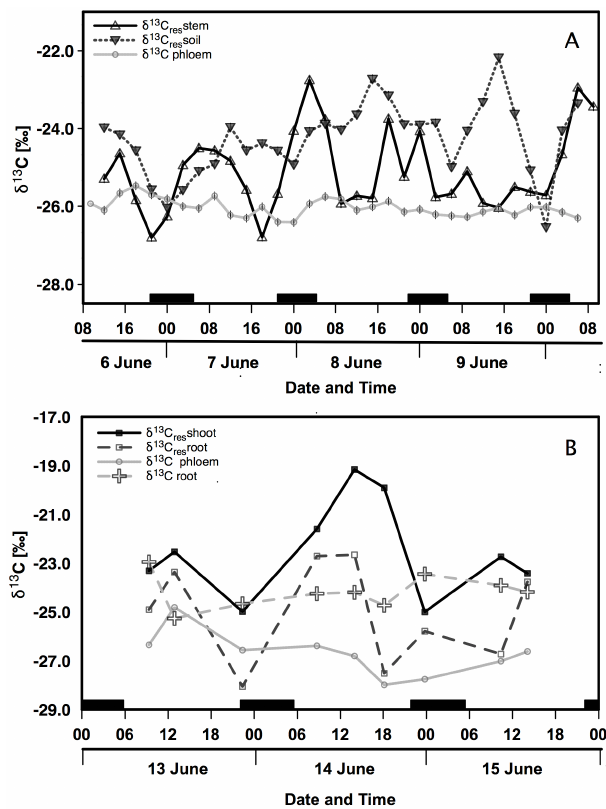
Fig. 1. Examples for diel variations in δ 13 C res and in δ 13 C of puta- tive respiratory substrates. (A) shows soil and stem δ 13 C res from a Pinus sylvestris forest compared to δ 13 C of phloem exudates (Ko- dama et al., 2008). (B) shows diel variations in shoot and root δ 13 Cres as compared to δ 13 C in phloem exudate and root water soluble organic matter in Triticum aestivum (Kodama et al., 2011). Gessler et al. (2009b) and Brandes et al. (2006) showed that the δ 13 C of water soluble organic matter is a reasonably good proxy for δ 13 C of the neutral sugar fraction and thus the major respiratory